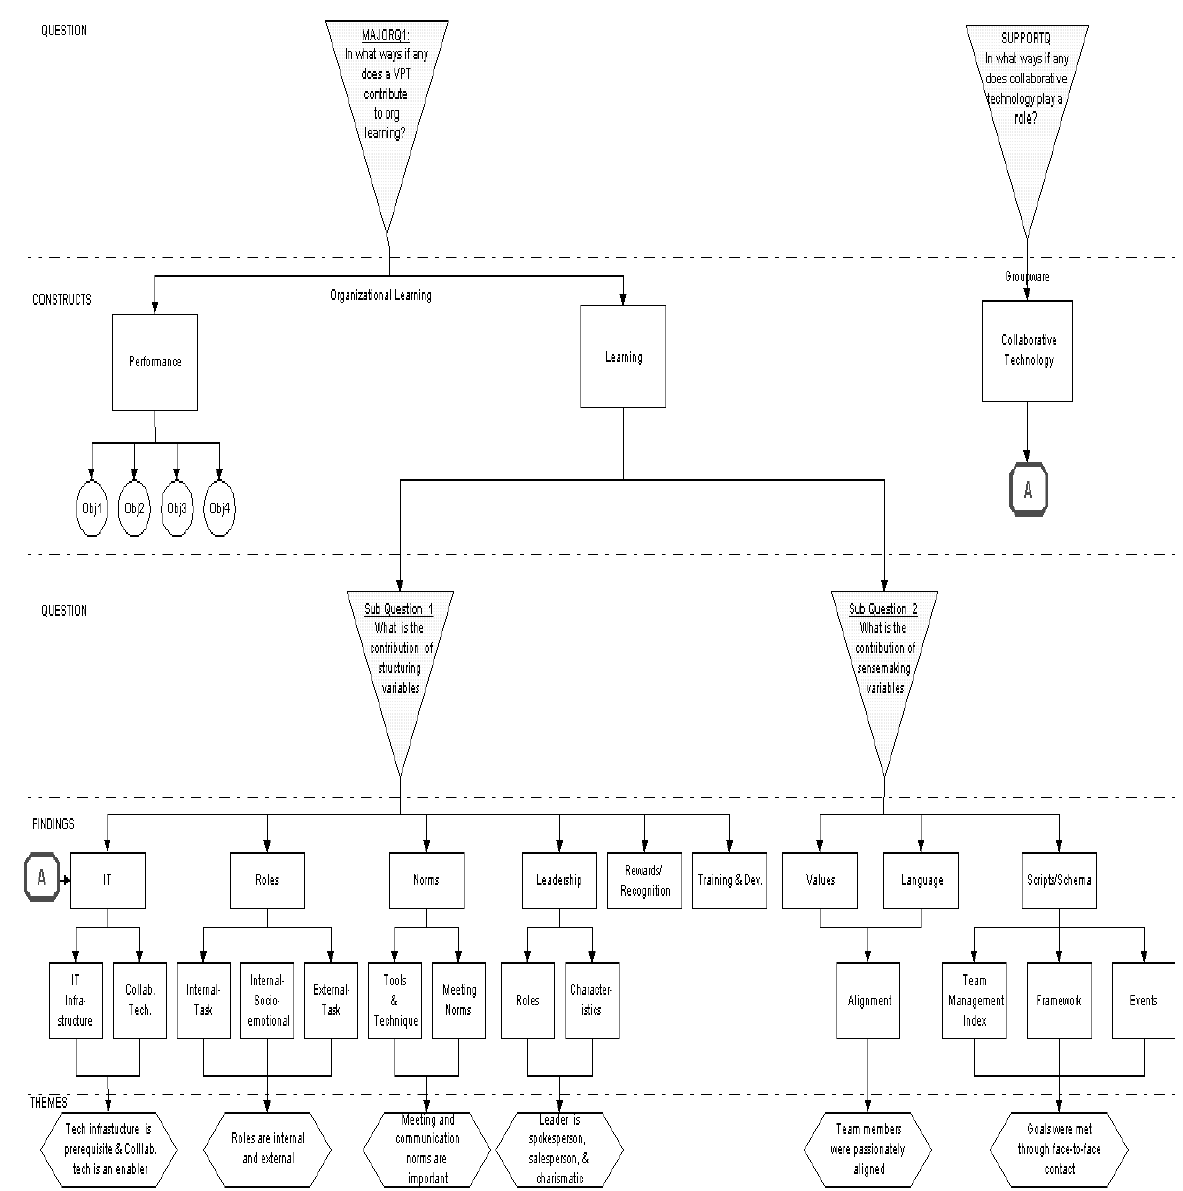
Figure 5: Flow of major research questions, findings and